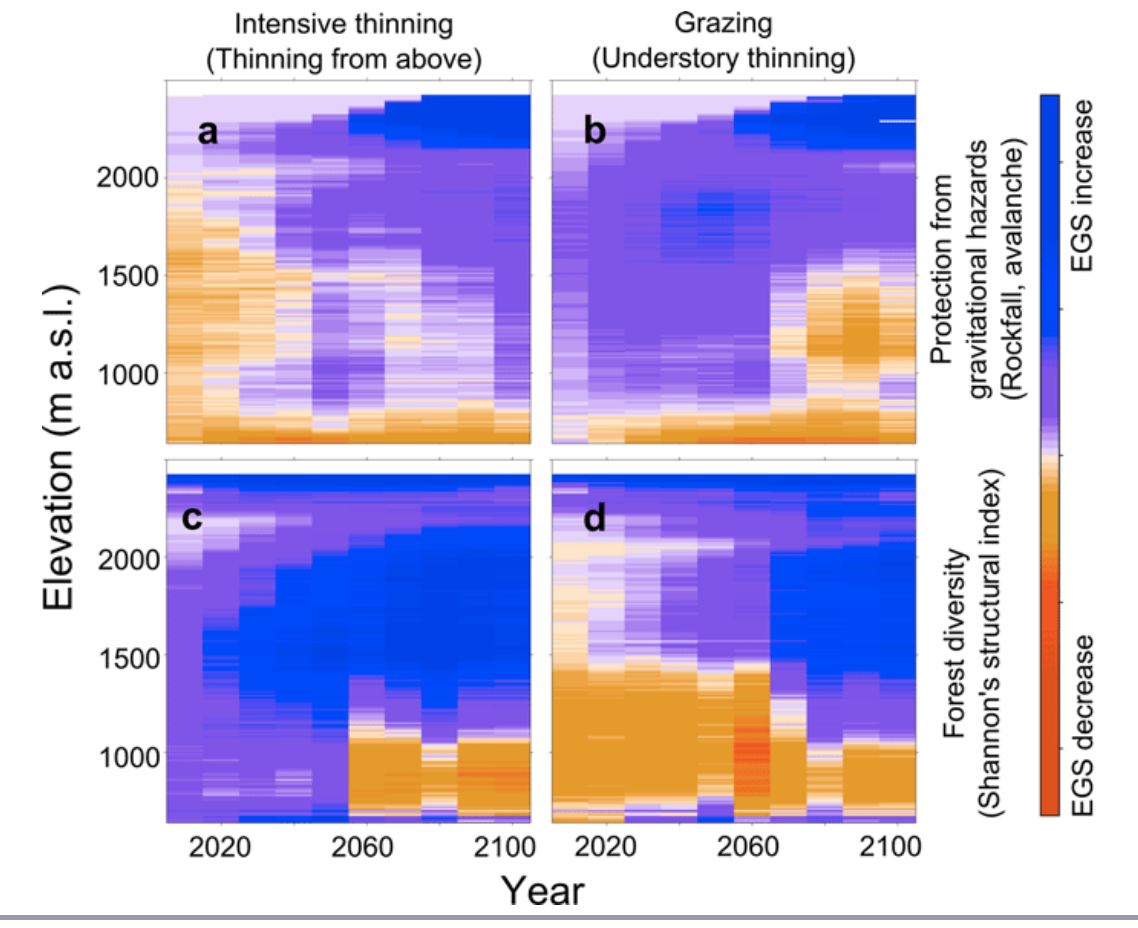
Fig. 3 . Illustrative example of forest ecosystem goods and services (EGS) trade-offs and heterogeneity arising from alternative management under climate change. Simulated impacts on the protective function that forests provide against gravitational hazards (a, b) and forest diversity (c, d) are shown. Projected changes in each EGS are represented as deviations from forest state in 2010. Intensive thinning, which is intended to increase forest vitality, initially decreased forests protective ability at intermediate and low elevations (a), but improved forest diversity (c). Later in the century intensive thinning is projected to increase the protective function of forests by facilitating a transition to more drought tolerant species. In contrast, understory thinning initially increases the protective ability of forests (b), but decreases forest diversity (d). Source: adapted from Rigling et al.